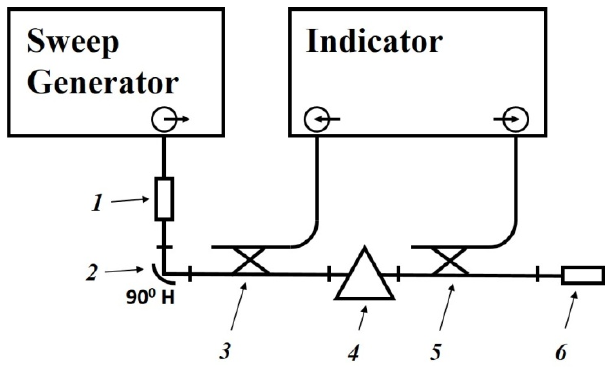
Figure 27. The scheme of the setup for measuring attenuation. (1) attenuator, (2) adapter, (3) incident wave DC, (4) measured object, (5) transmitted wave DC, and (6) matched load.